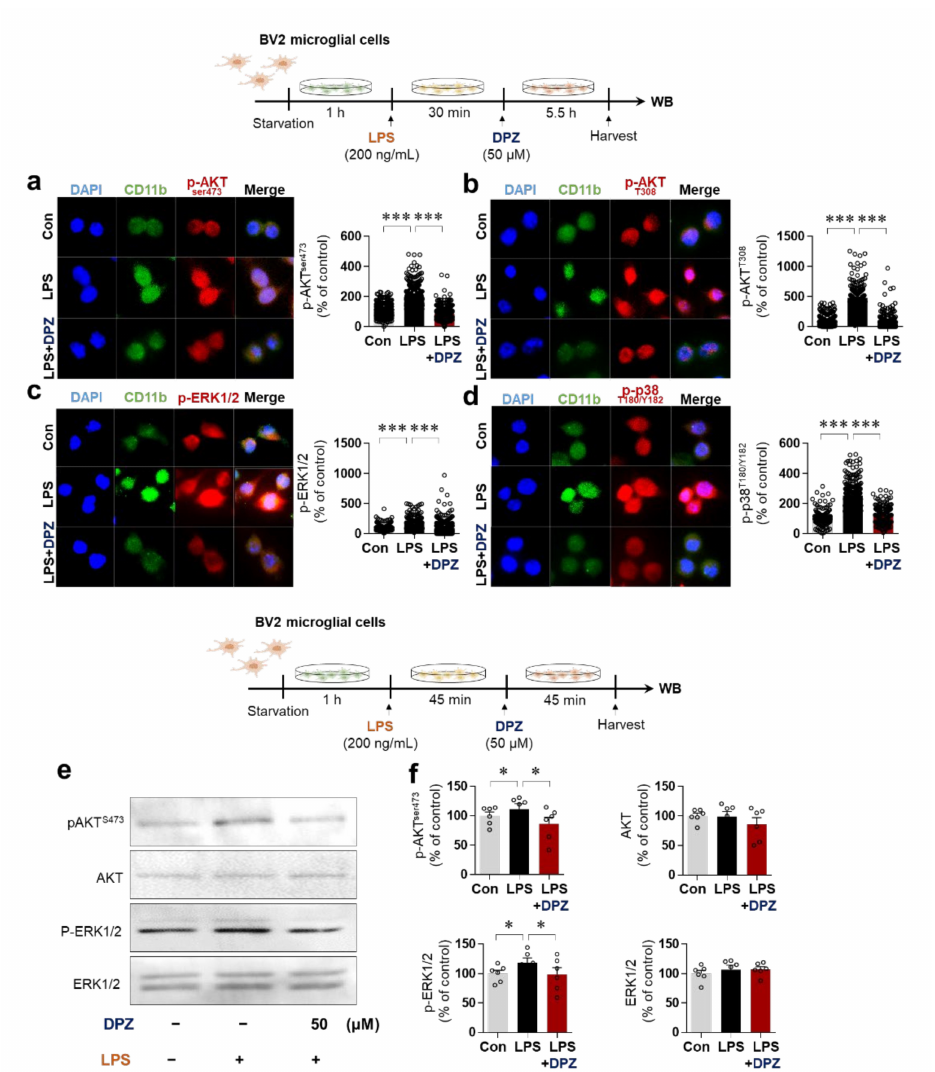
Figure 3. DonepezilaffectsLPS-mediatedAKT/MAPKsignalinginBV2microglialcells. ( a , b )p-AKT ser473 , p-AKT T308 , and CD11b expression in cells pretreated with LPS (200 ng/mL) or PBS and treated with donepezil (50 µ M) or vehicle (1% DMSO) as shown at the top of the figure (p-AKT ser473 ; Con: n = 434, LPS: n = 478, LPS + Donepezil: n = 400; p-AKT T308: Con: n = 231PS: n = 231, LPS + Donepezil: n = 206). ( c , d ) p-ERK, p-P38 T180/Y182 , and CD11b expression in cells treated as in ( a , b ) (p-ERK1/2(p44/42): Con: n = 189, LPS: n = 195, LPS + Donepezil: n = 233; p-P38 T180/Y182 : Con: n = 191, LPS: n = 231, LPS +